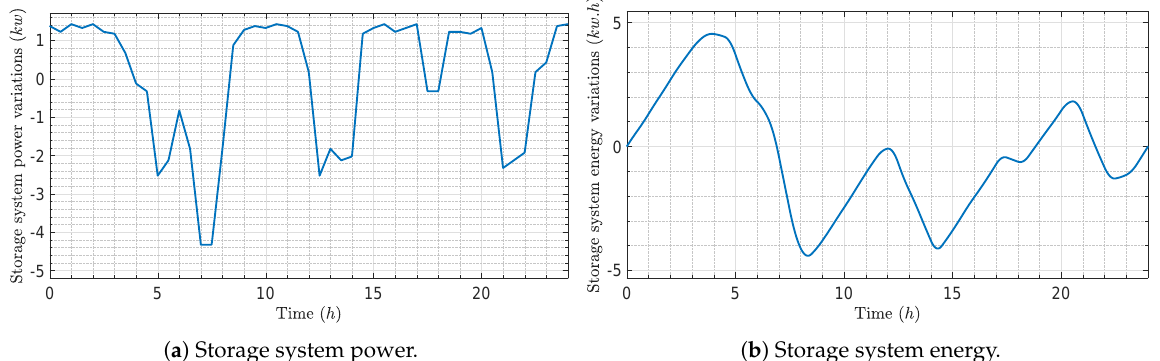
Figure 3. Daily flywheel power and energy